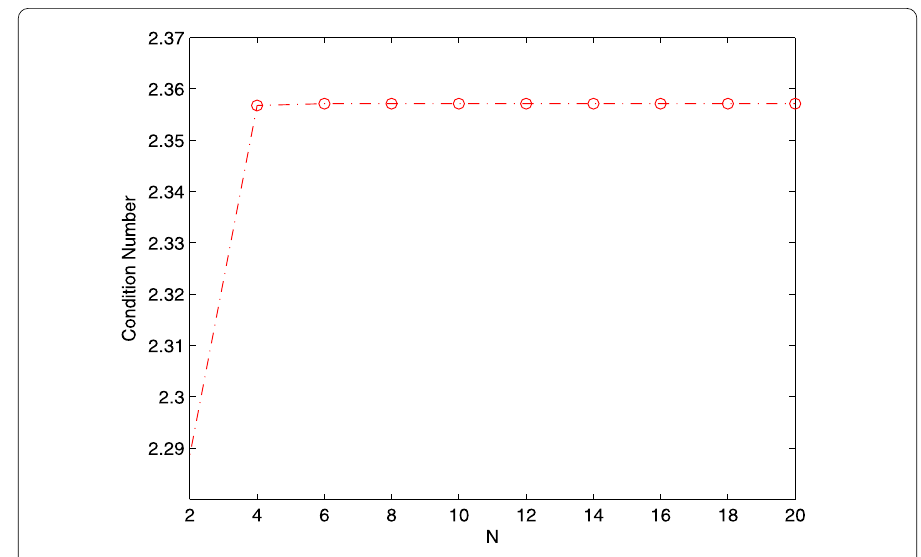
Figure 2 Condition number of the matrix S – T with Example 5.1